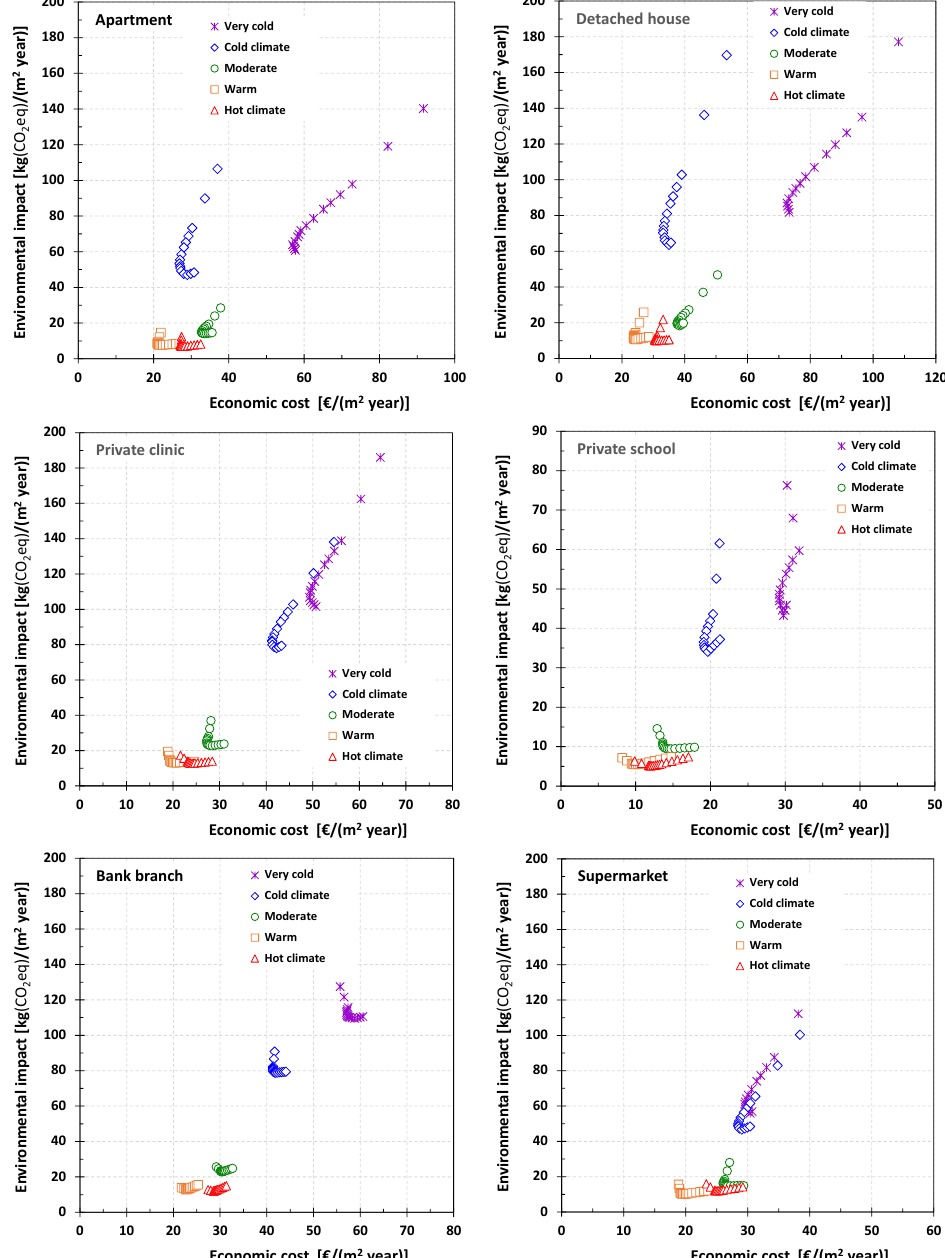
Figure 7. Relationship between the environmental impact and the economic cost.